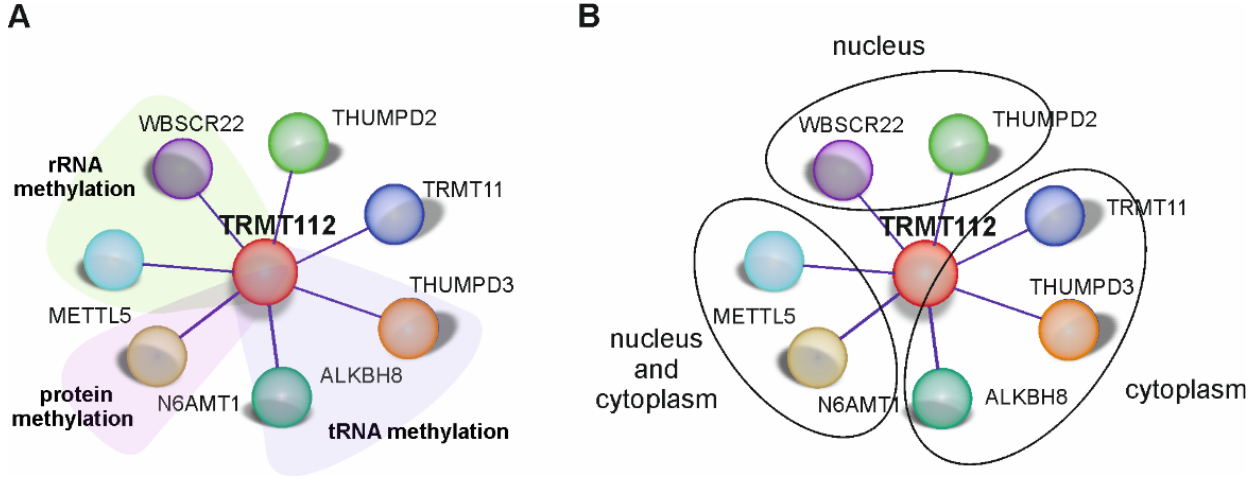
Figure 6. TRMT112 interactome. MTases interacting directly with TRMT112 are shown together with their known enzymatic activities ( A ) and cellular localisation ( B ).